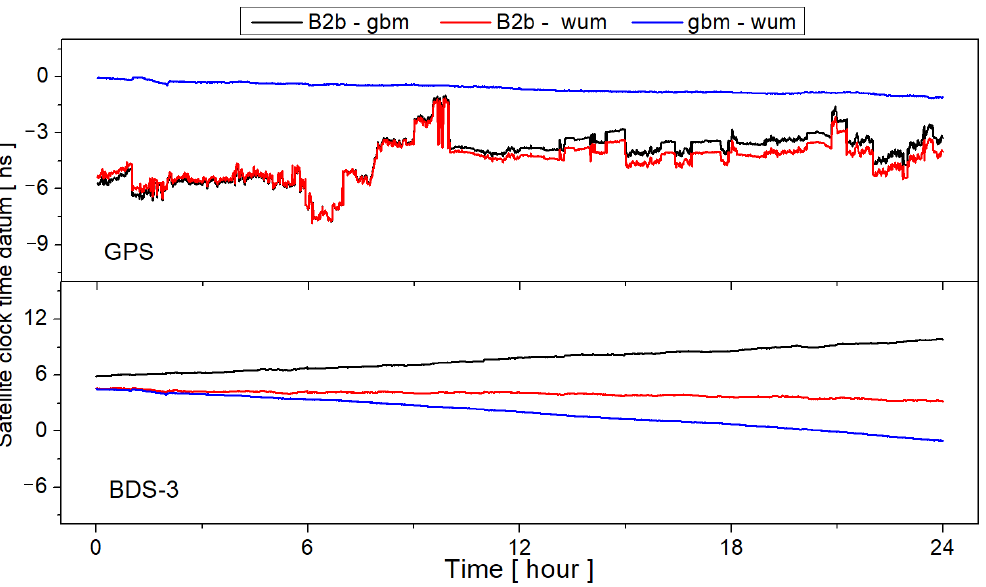
Figure 2. Satellite clock time datum between different products in MJDN 59100 (8 September 2020); B2b, gbm, and wum represent products of PPP-B2b, GFZ, and WHU; constant values are added to the time datum series for comparison.